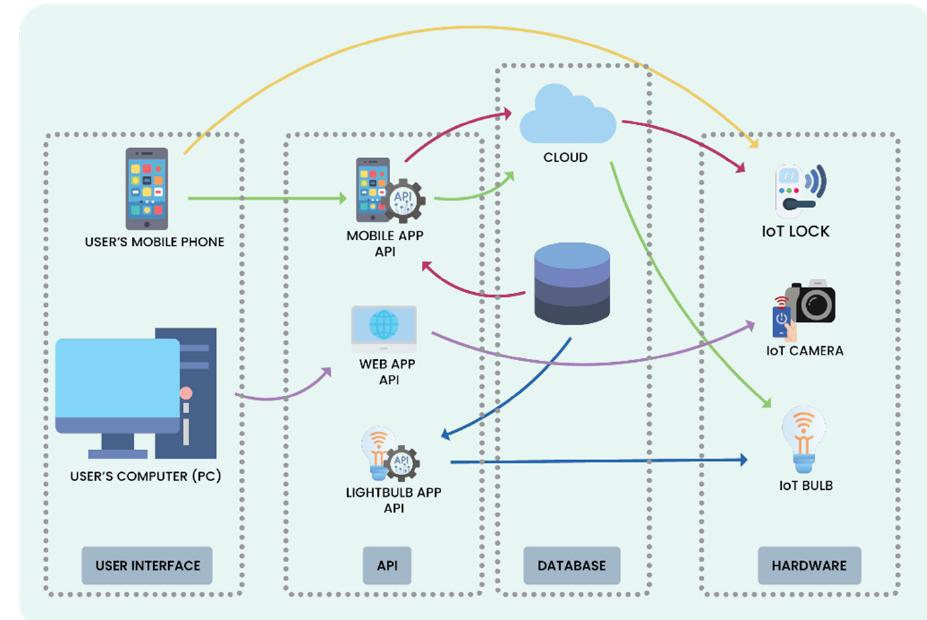
Figure 1. The architecture of a Smart home .